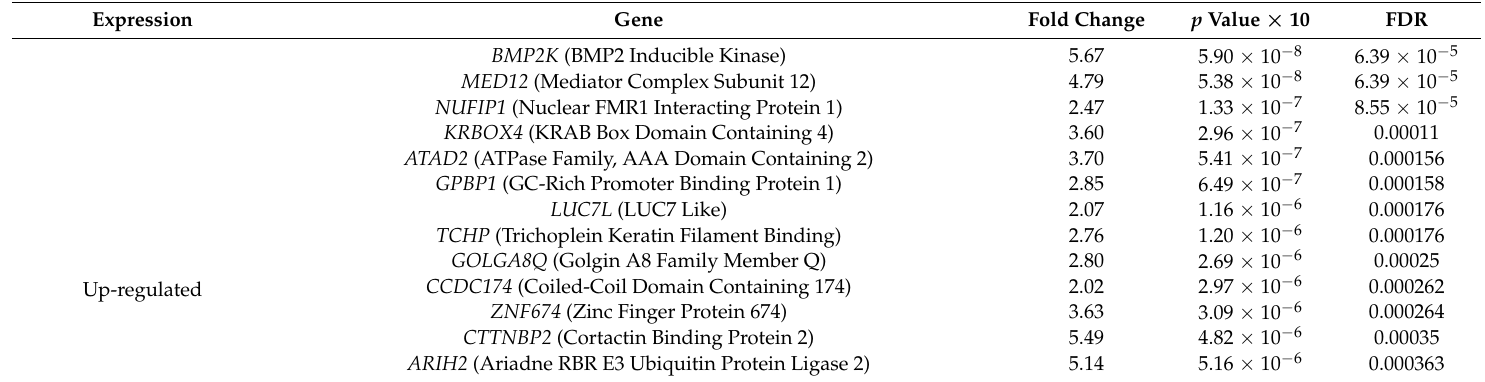
Table 2. Top 20 differentially expressed genes in parathyroid adenoma with respect to the normal parathyroid